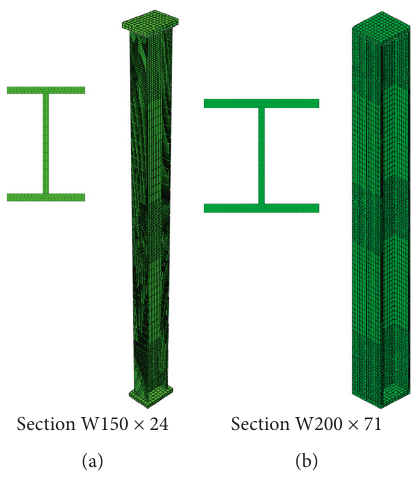
Figure 1: Numerical models used to simulate steel columns’